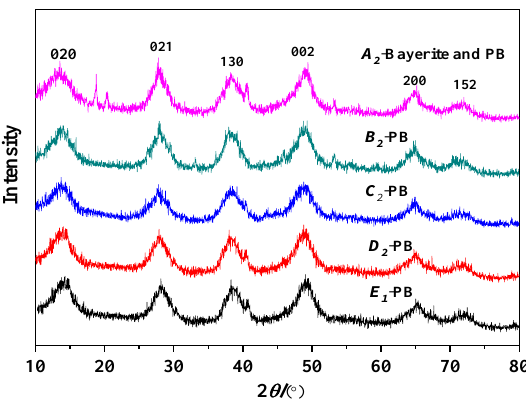
Figure 7. XRD results of PB with different rotating speeds of CF-RPB on pore properties (concentration of NaAlO 2 solution, 0.1 mol/L; gas – liquid ratio, 3:1). Nanomaterials 2020 , 10 , 263